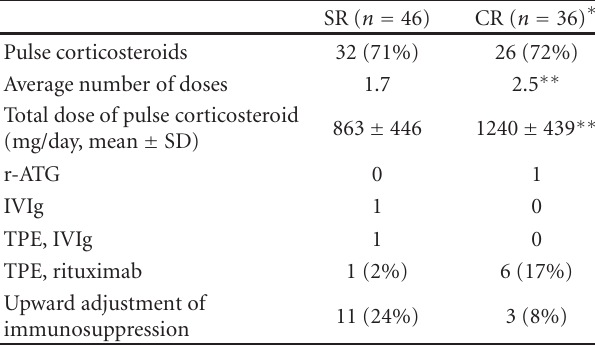
Table 5: Treatment of acute